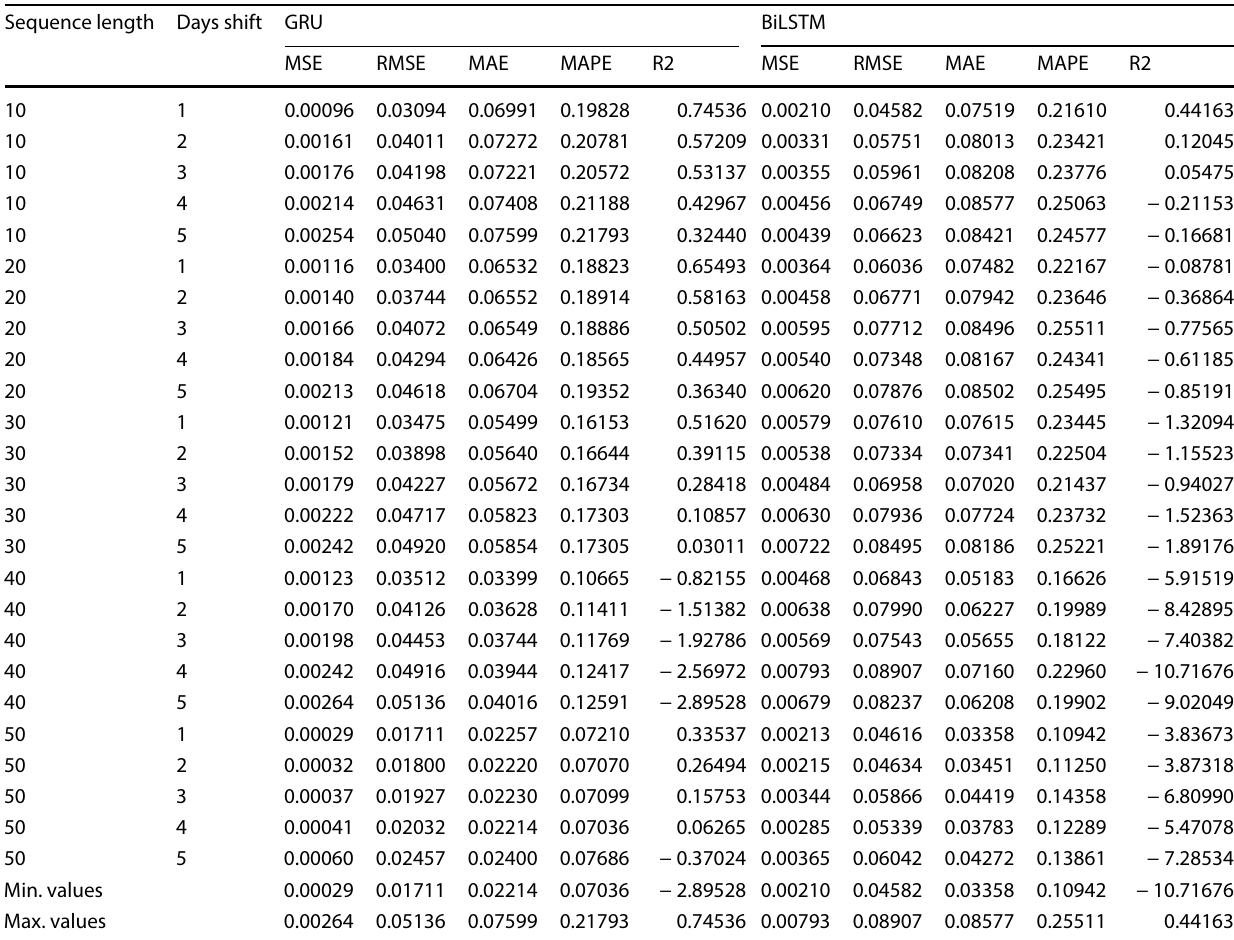
Table 5 The reported performance metrics for the “Bitcoin USD (BTC-USD)” dataset using the two models (i.e., GRU and